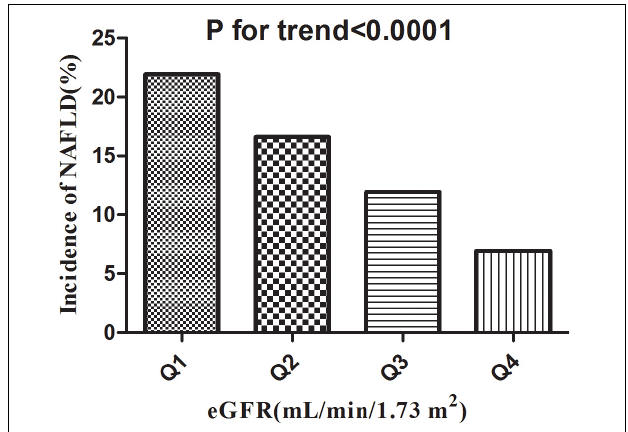
FIGURE 5 | Incidence of NAFLD according to the quartiles of eGFR. Participants in the high eGFR group had a lower NAFLD incidence than the lowest eGFR group ( p < 0.0001 for